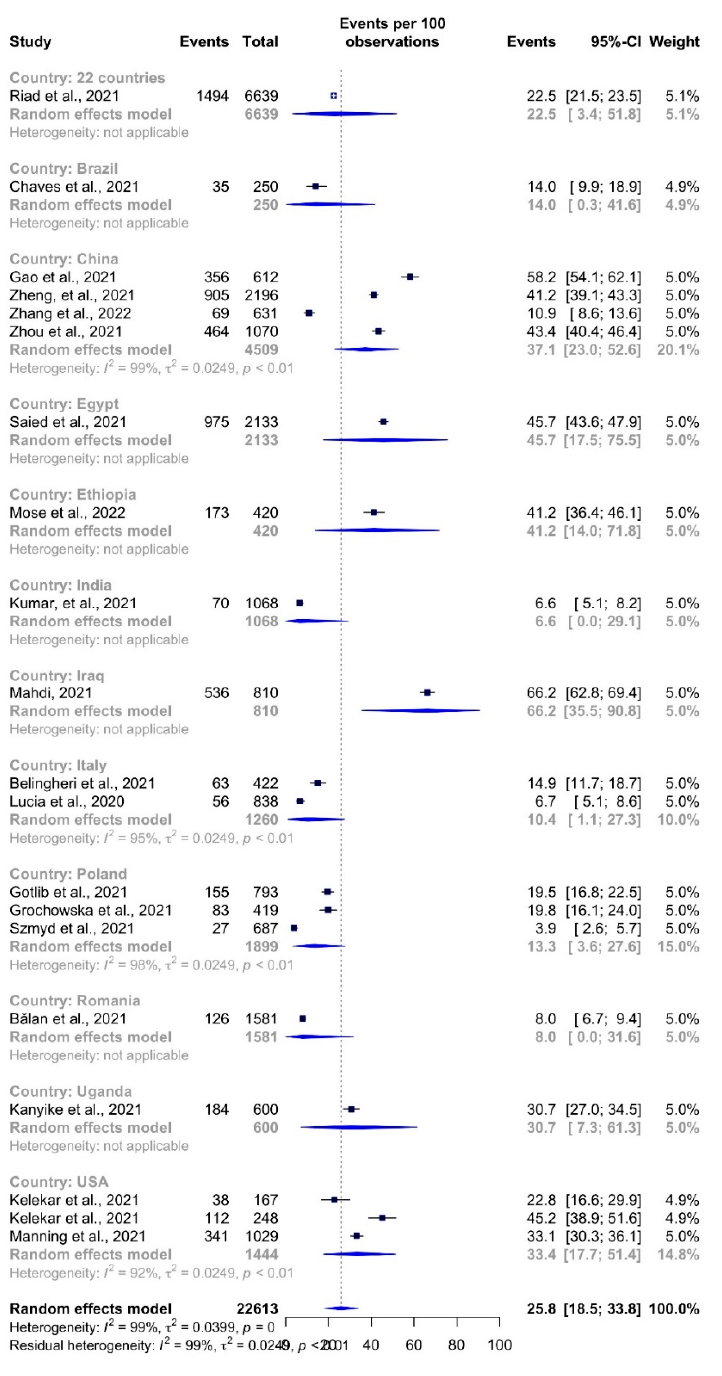
Figure 6. COVID-19 vaccine hesitancy rates among healthcare students by country.